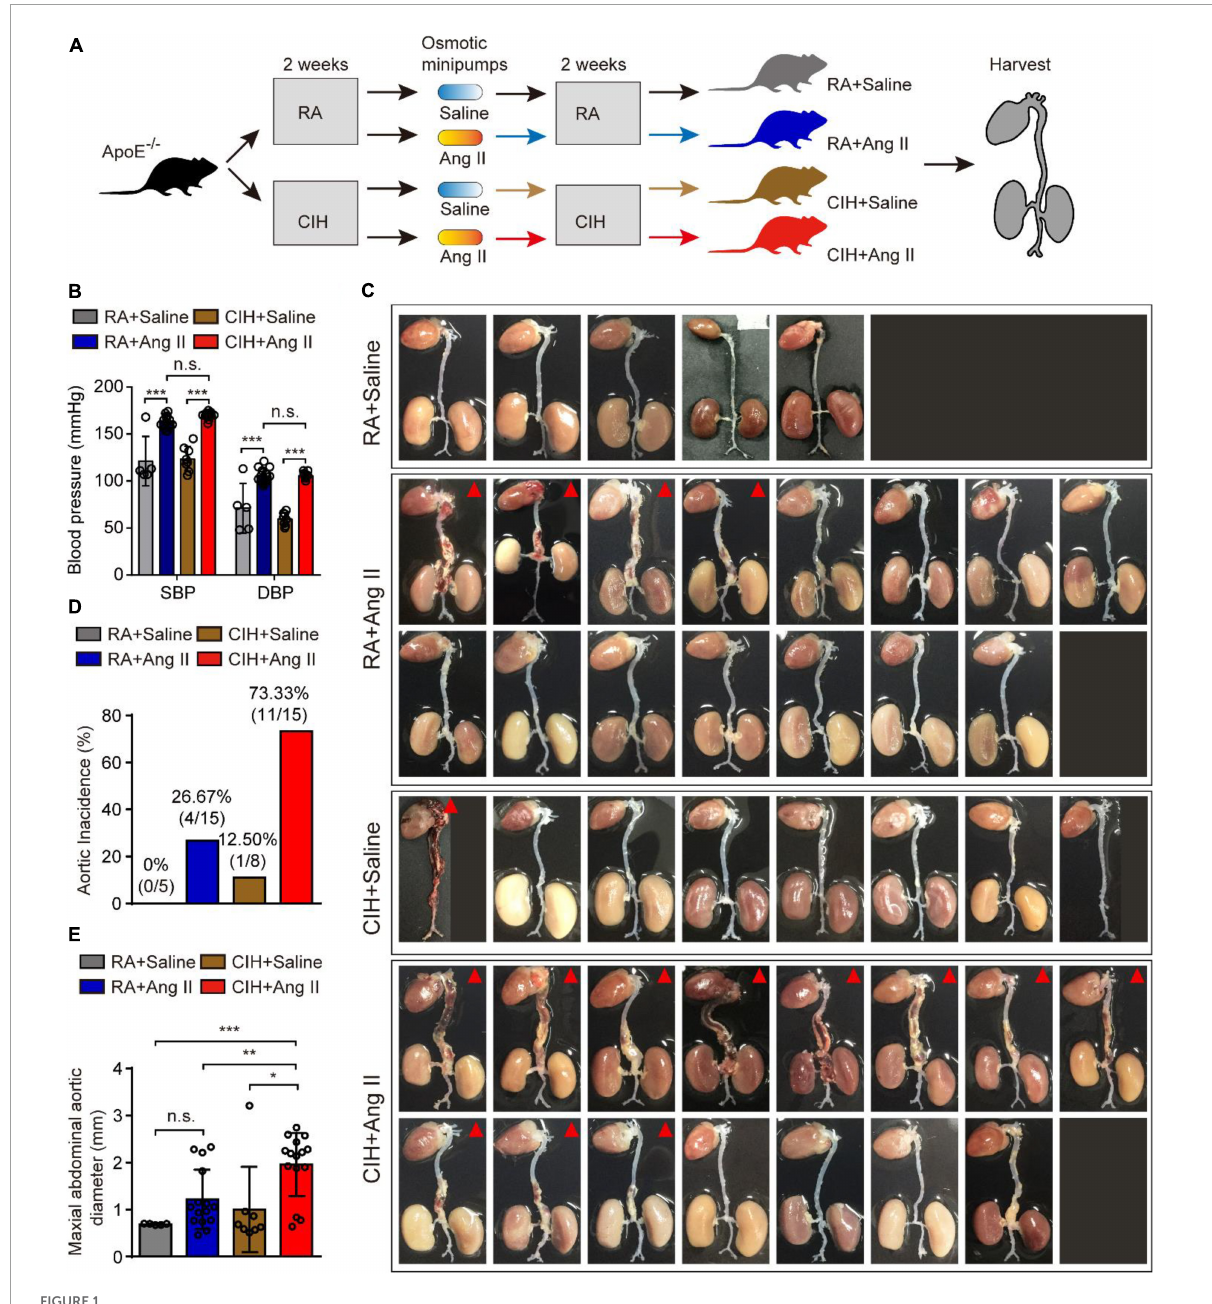
FIGURE1 The establishment of the aortic dissection (AD) mouse model induced by chronic intermittent hypoxia (CIH) and Ang II. (A) Diagram illustrates the experimental design for establishing the AD model. Briefly, ApoE - / - mice were preprocessed in the CIH system [room air (RA)-pretreated mice were used as control] for 2 weeks. Next, mice were implanted with microosmotic pumps filled with Ang II (saline was used as control). Then, mice received the CIH treatment (RA for control mice) for 2 weeks. Finally, aortic tissues were obtained from all animals. (B) The blood pressure of mice after CIH/RA and Ang II/saline administration. (C) Whole aorta tissue from the indicated mice after CIH/RA and Ang II/saline administration. The red triangle shows mice with aortic accident. (D) The histogram shows the ratio of aortic accident in the four groups of mice. (E) The histogram shows the maximal abdominal aortic diameter in the four groups of mice. For panels (B–E) , n = 5–15 mice per group; n.s., not significant; * P < 0.05, ** P < 0.01, *** P < 0.001.